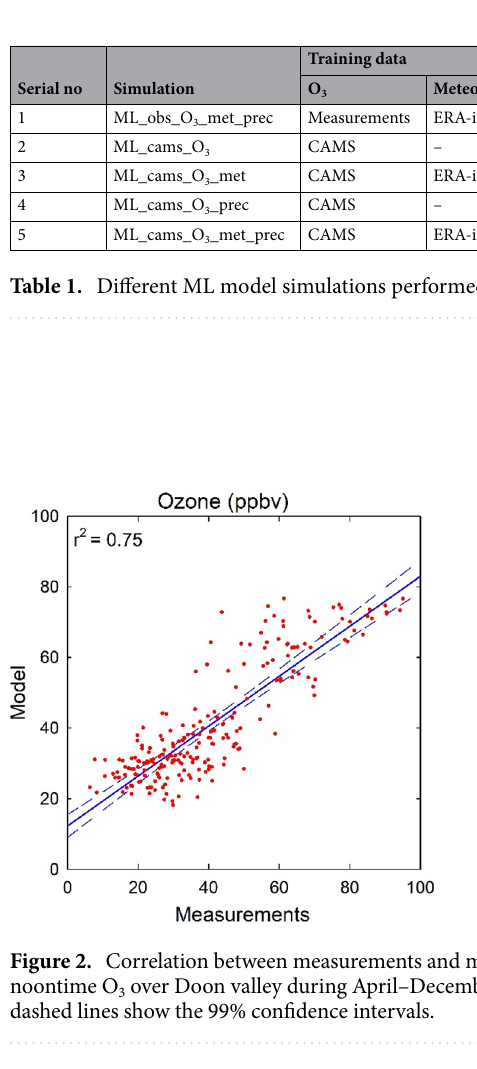
Figure 1. Flow chart of the steps in building the ML model for simulation of urban O 3 variations and evaluation.